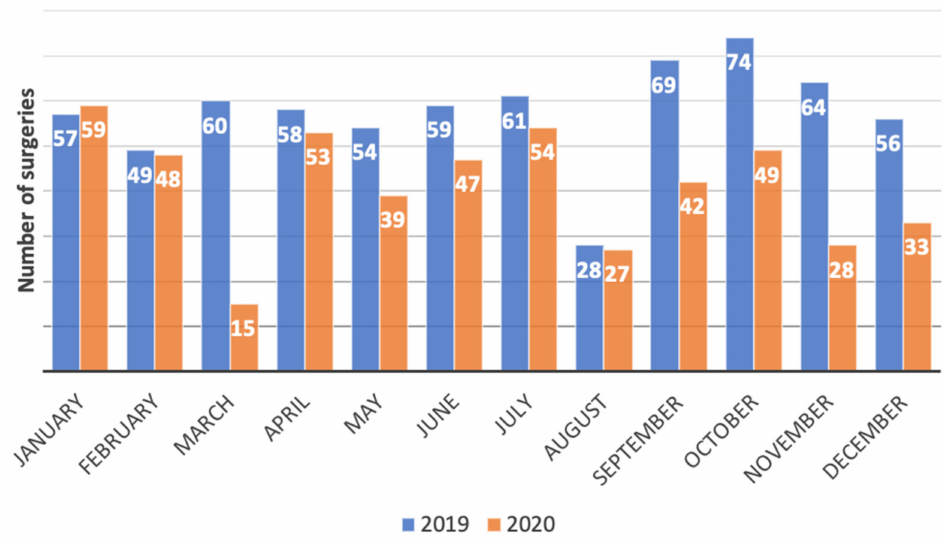
Figure 1. Monthly distribution of the overall number of urologic oncology surgeries performed by the Niguarda urology surgery team: comparison between 2019 and